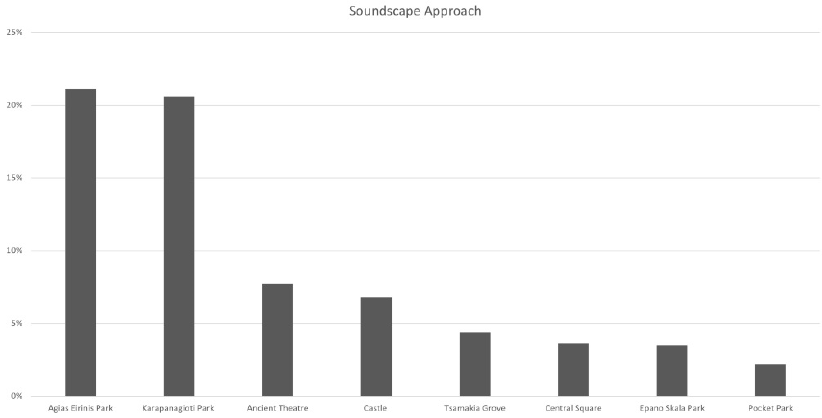
Figure 5. Potential quiet areas ranked using the soundscape approach. Figure 5. P ot ential quiet areas ranked using the soundscape approach.